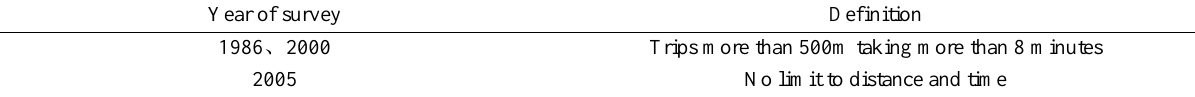
Table 2: The discrepancies in the definitions of “trip” in different surveys